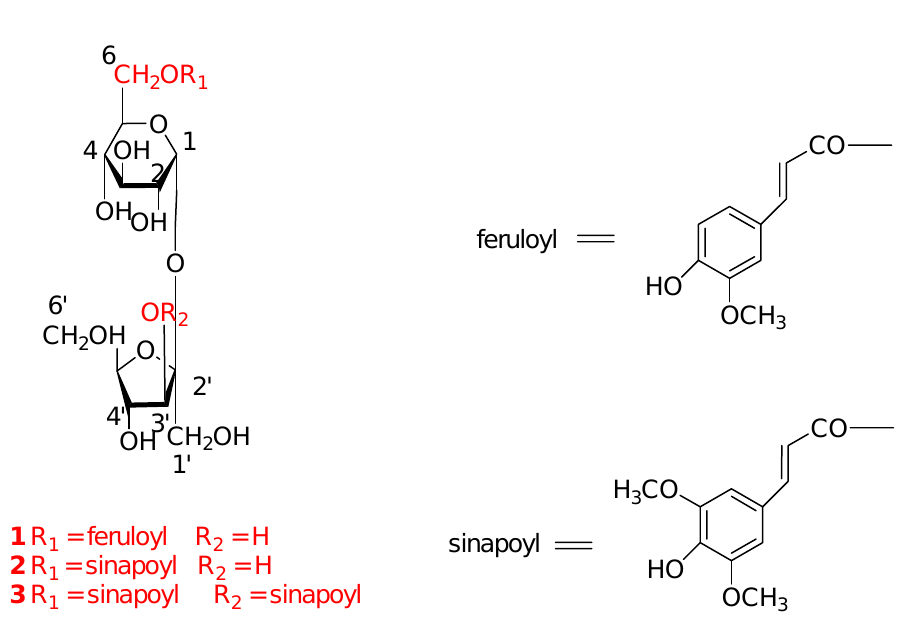
Figure 1. Structures of compounds 1 - 3